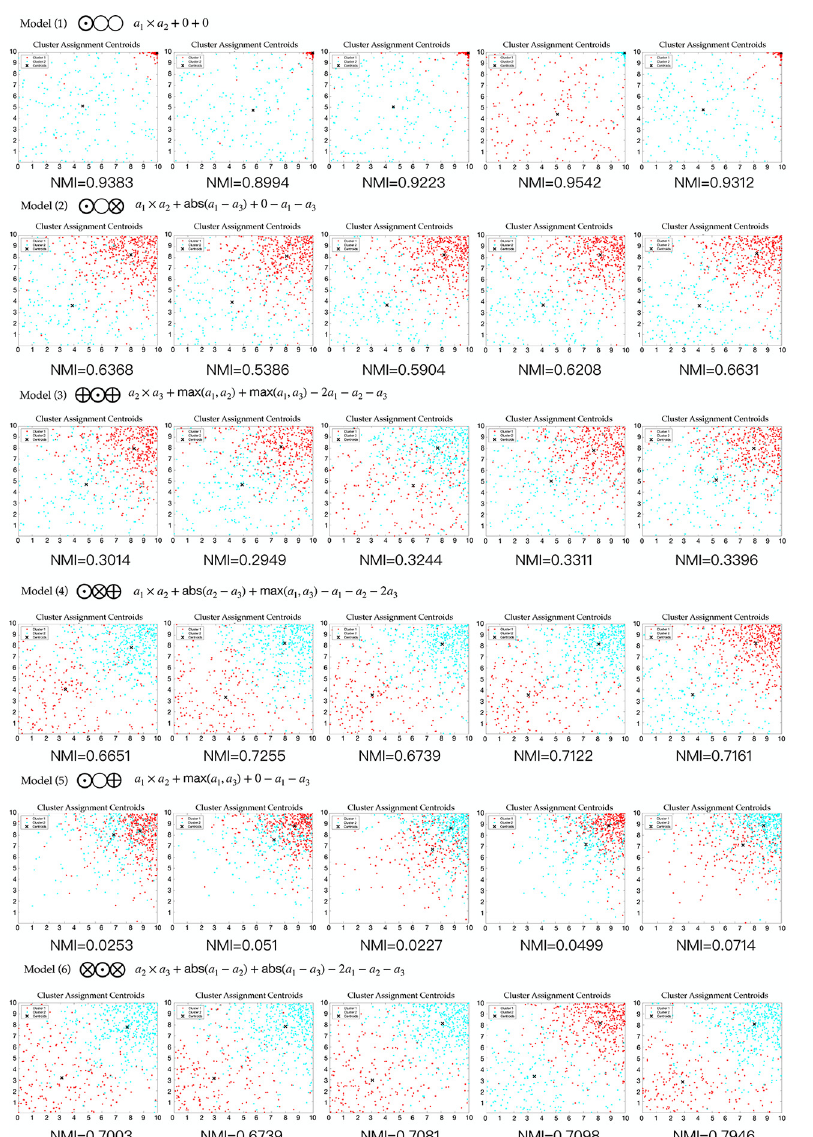
Figure 5. Five independent clustering results of six crowd intelligence evolution under k =